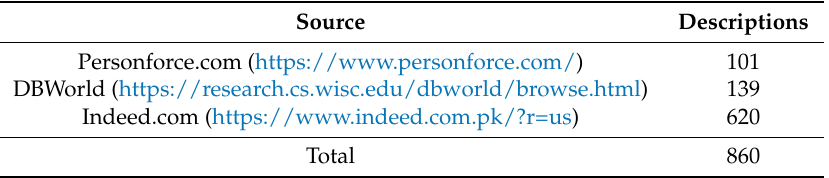
Table 9. Statistics of jobs collected from various e-recruitment systems.